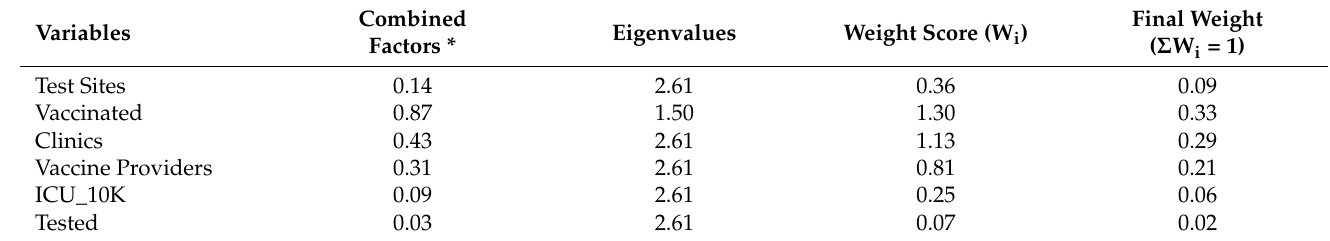
Table 6. Eigenvalues and weight scores for the Adaptive Capacity